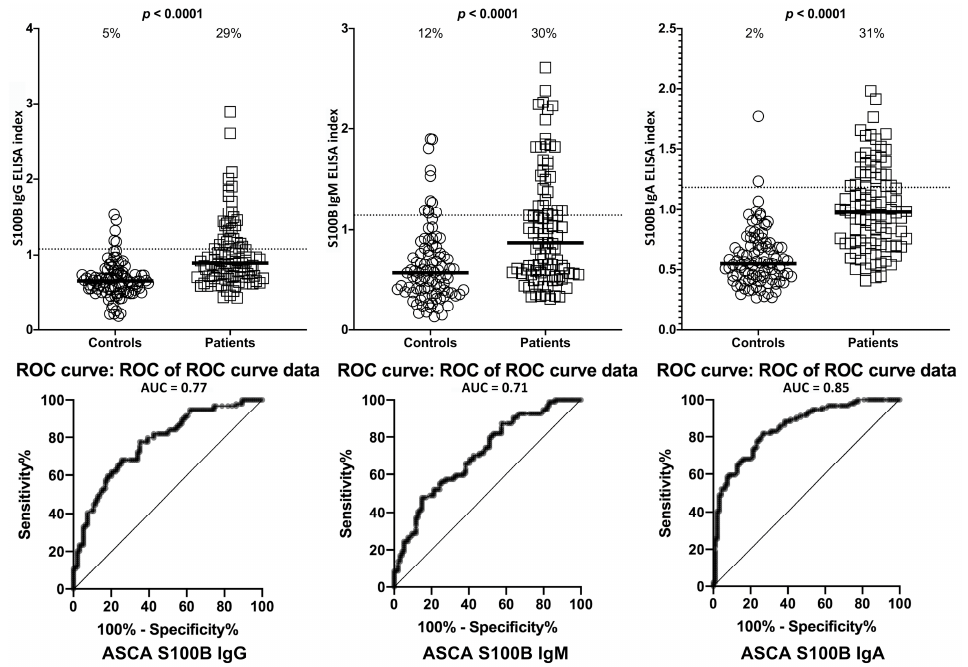
Figure 3. Percentage of elevation of IgG, IgM, and IgA antibodies against S100B in 94 patients positive for ASCA and in 94 healthy controls. Dotted lines indicate the cuto ff for positivity used in each assay, as calculated by ROC analysis. The percentage of elevation is indicated on top of each distribution, while bars indicate the corresponding median. The AUC for S100B IgG was 0.77, 0.71 for S100B IgM, and 0.85 for S100B IgA.